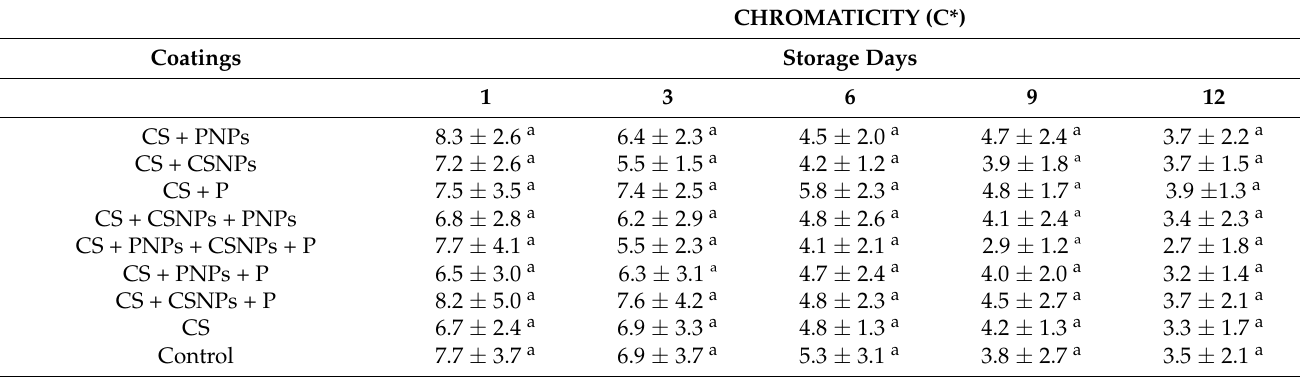
Table 3. Effect of edible chitosan/propolis coatings on the colour (chromaticity) of fig fruit stored for 12 days at 4 ◦ C.